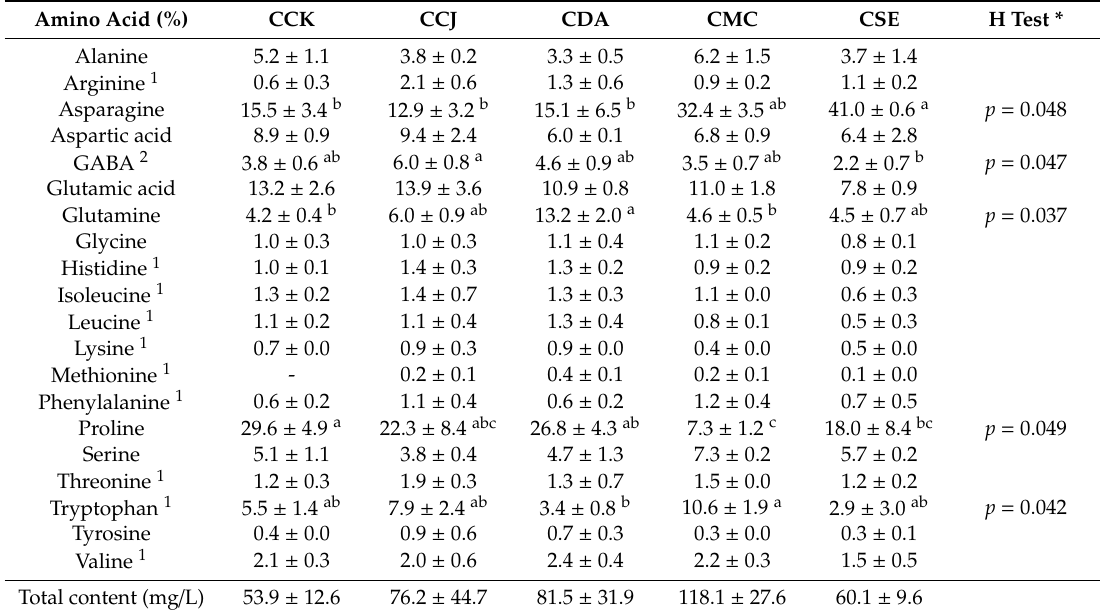
Table 3. The composition of amino acid in nectar of Castenea spp. male